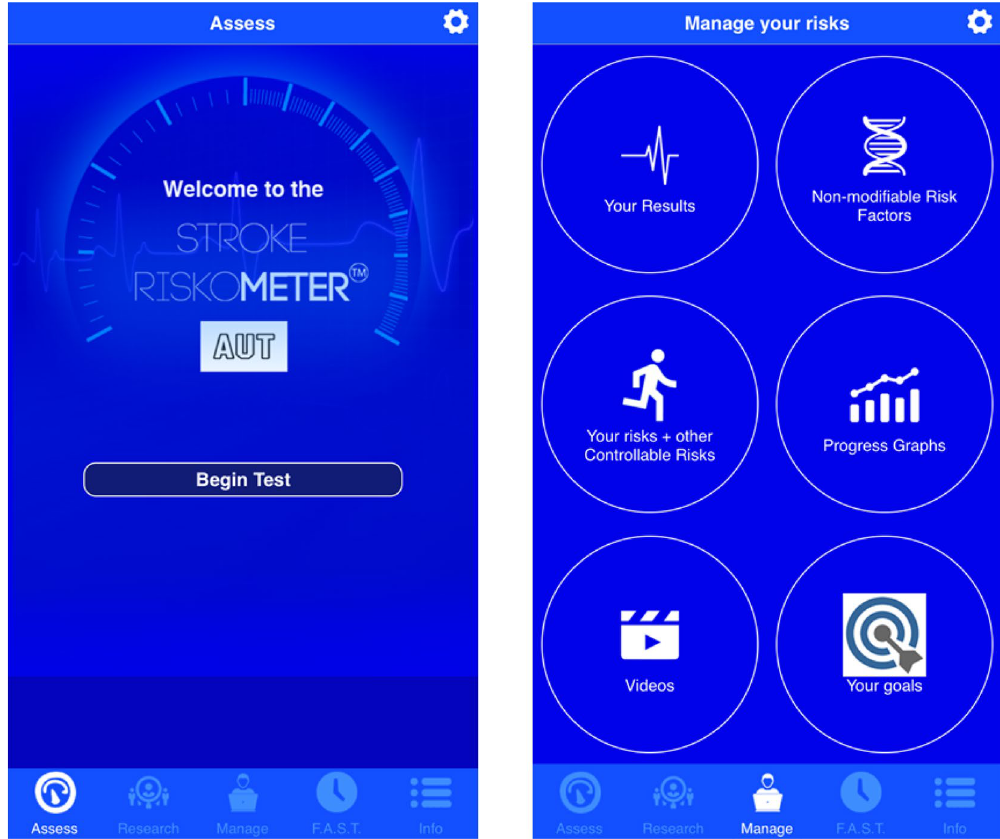
Figure 1. Stroke Riskometer mobile application front